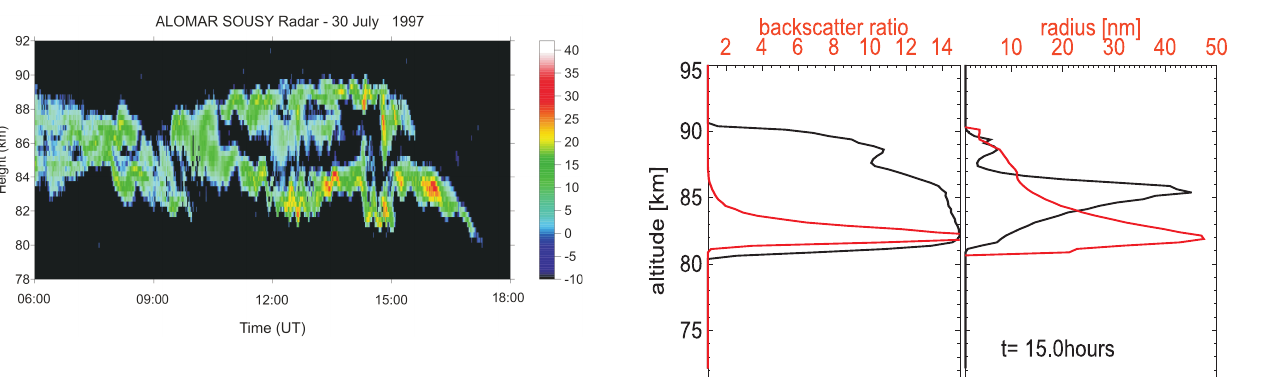
Fig. 1. Signal-to-noise ratio in dB of the backscattered echo power, derived from measurements with the VHF radar at Andenes with the vertically directed beam on 30 July 1997.